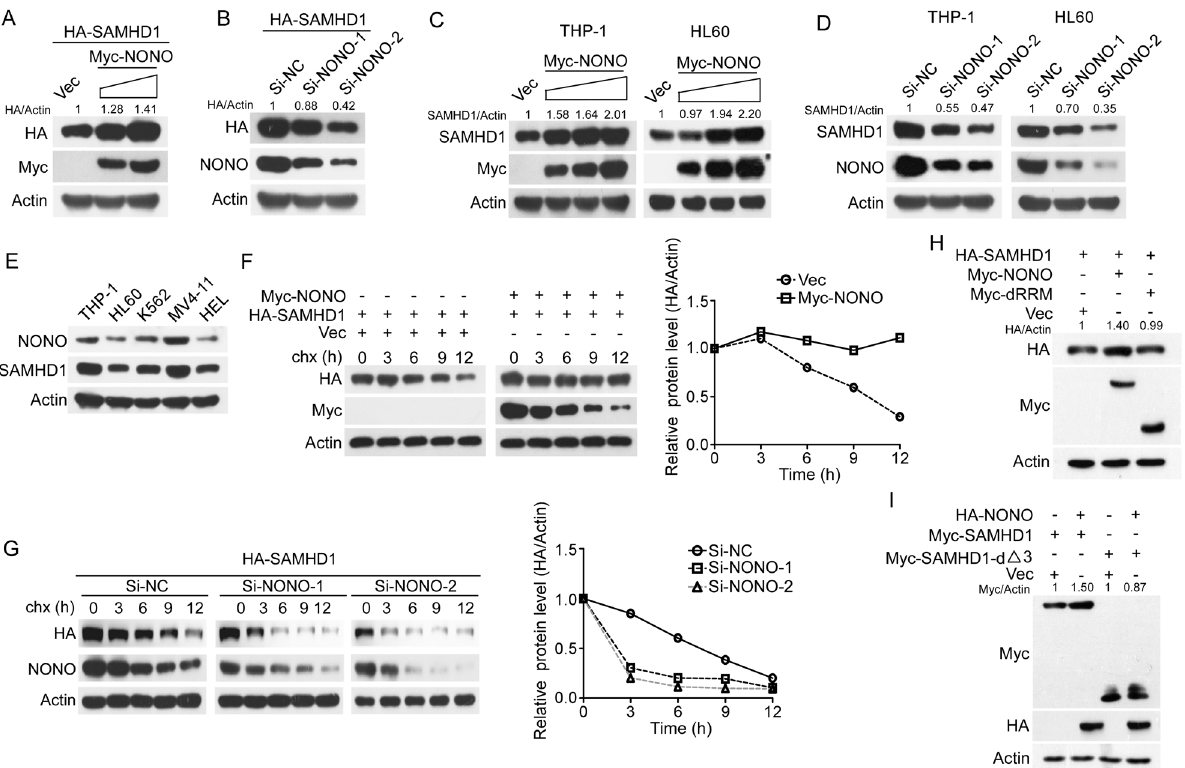
Fig. 2 NONO improves the stability of SAMHD1. A – D Overexpression or silencing of NONO decreased or increased both the exogenous and endogenous expression of SAMHD1, respectively. A 293 T cells transfected with HA-SAMHD1 and increasing concentrations of Myc-NONO for 24 h were lysed and the levels of the indicated proteins were evaluated using western blotting. B 293 T cells transfected with NONO siRNAs for 24 h were then transfected with HA-SAMHD1 for 24 h and the levels of the indicated proteins were evaluated using western blotting. C AML cells were transfected with increasing concentrations of Myc-tagged NONO for 24 h, and the levels of the indicated proteins were evaluated using western blotting. D AML cells were transfected with NONO or negative control siRNAs for 72 h, and the levels of the indicated proteins were evaluated using western blotting. E Expression levels of NONO and SAMHD1 in AML lines. THP-1, HL60, K562, MV4-11, and HEL cells were cultured for 24 h, and the levels of the indicated proteins were evaluated by western blotting. F , G CHX chase assays con fi rmed that NONO improves the stability of SAMHD1. F HA-tagged SAMHD1 was cotransfected with or without Myc-tagged NONO into 293 T cells for 24 h, and the cells were treated with CHX for the indicated time before harvesting. G 293 T cells transfected with NONO or negative control siRNAs for 48 h were treated with CHX for the indicated time before harvesting. The levels of the indicated proteins were determined by western blotting (left) and quantitative analysis (right). H Deletion of the RRM domain of NONO does not increase SAMHD1 expression. HA-tagged